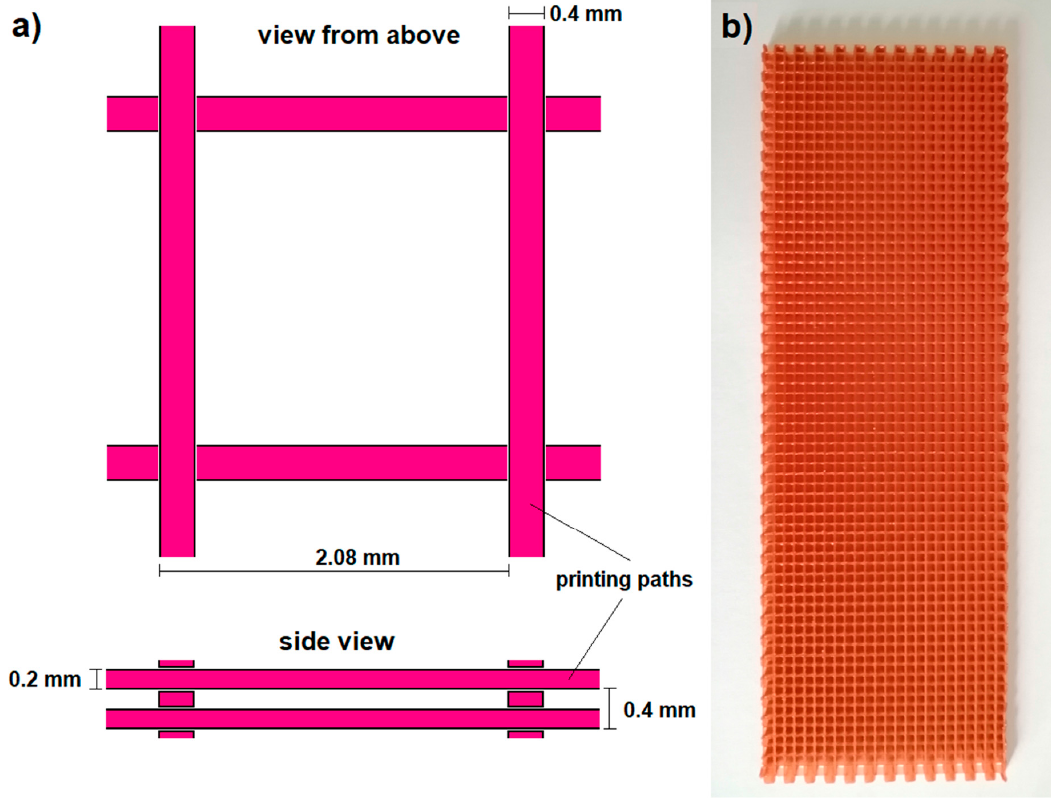
Figure 1. The printed grid: ( a ) a scheme of the arrangement of paths in a single “cell” of the printout, ( b ) an exemplary printed grid with dimensions of 150 × 50 mm.